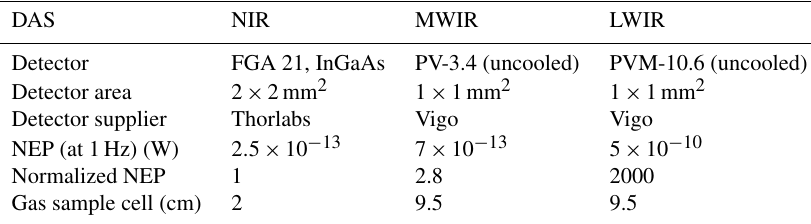
Table 2. Detector and gas cell properties for the DAS